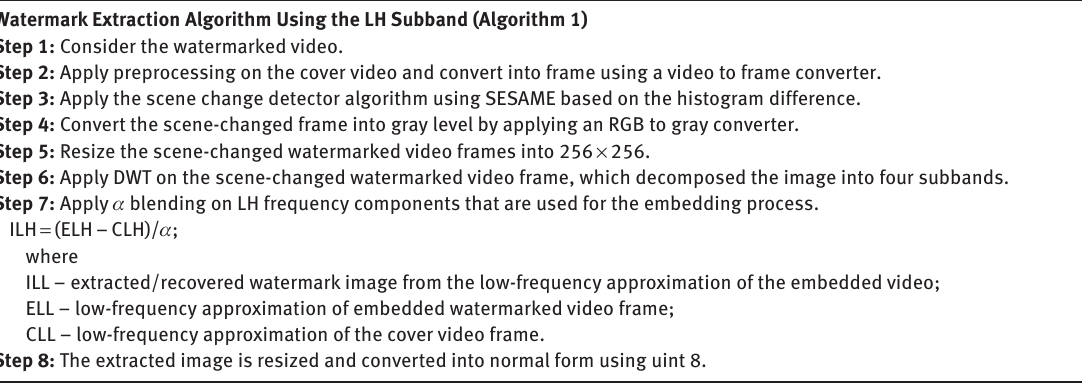
Watermark Extraction Algorithm Using the LH Subband (Algorithm